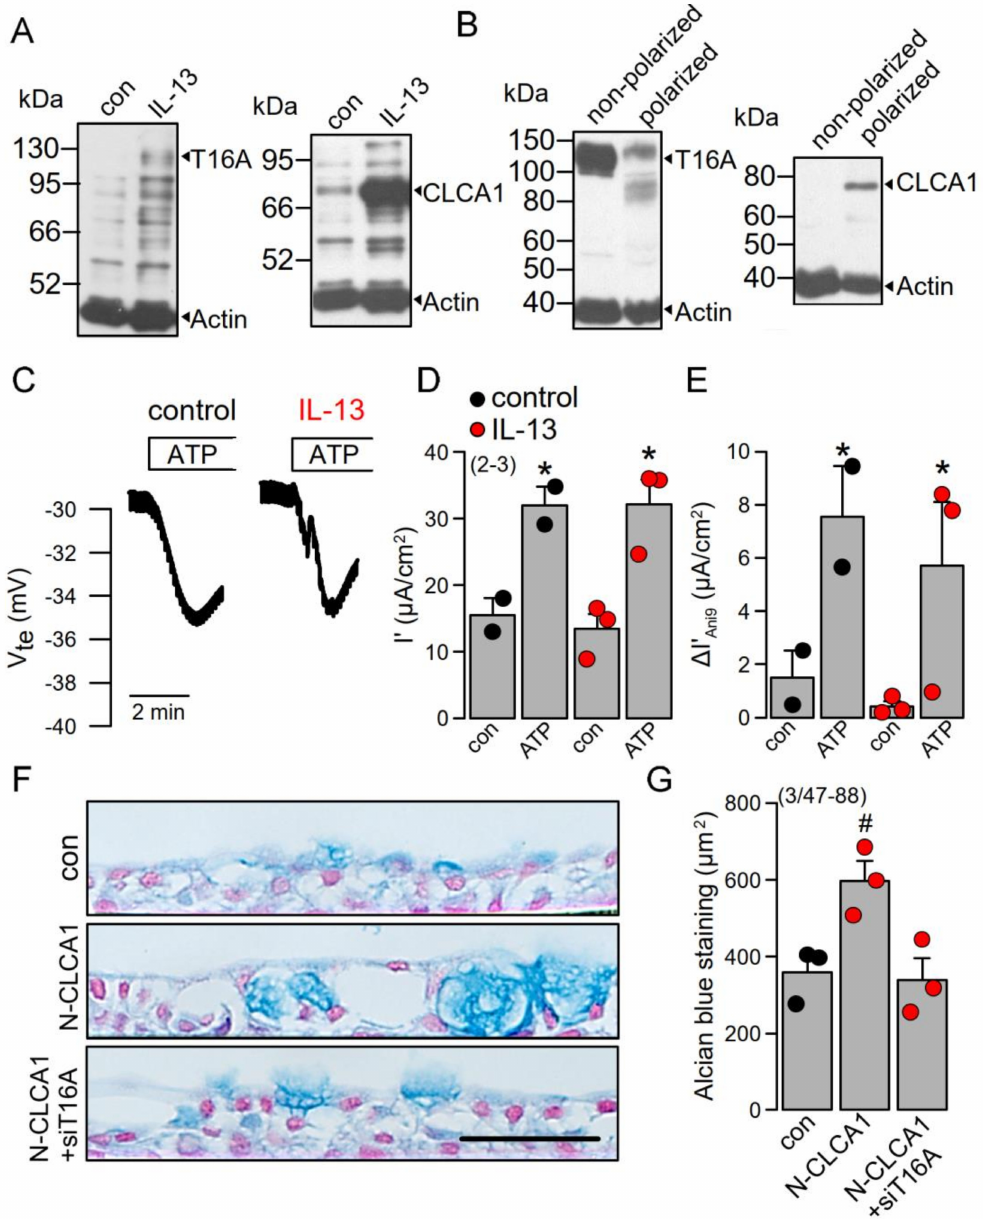
Figure 6. CLCA1-induced mucus production in polarized BCi-NS1 cells is TMEM16A-dependent. A , B ) Western blot indicating upregulation of CLCA1 expression in BCi-NS1 cells exposed to IL-13 (20 ng/mL). Expression of TMEM16A was found to be attenuated in polarized grown cells (filter-grown ALI-cultures), when compared to nonpolarized (plastic-grown) cells. In contrast, CLCA1 expression was upregulated in ALI cultures. (number of experiments). ( C , D ) IL-13 does not enhance ATP-induced (100 µ M) negative voltage deflections and activation of short circuit currents (Isc). Activation of Isc was fully transient, i.e., the current returned to the baseline. ( E ) The effect of the TMEM16A inhibitor Ani9 (10 µ M) is not enhanced in IL-13 treated cells. ( F , G ) Individual examples and quantification of alcian blue staining in polarized BCi-NS1 cells under control conditions, after exposure to N-CLCA1 or in cells treated with N-CLCA1 and siTMEM16A. Mucus expression is enhanced in N-CLCA1-treated cells, but the effect of N-CLCA1 is blocked after knockdown of TMEM16A. (number of experiments). Scale bar = 50 µ m. Mean ± SEM. # significant difference when compared to control ( p < 0.05; unpaired t -test). * significant activation by ATP ( p < 0.05; paired t